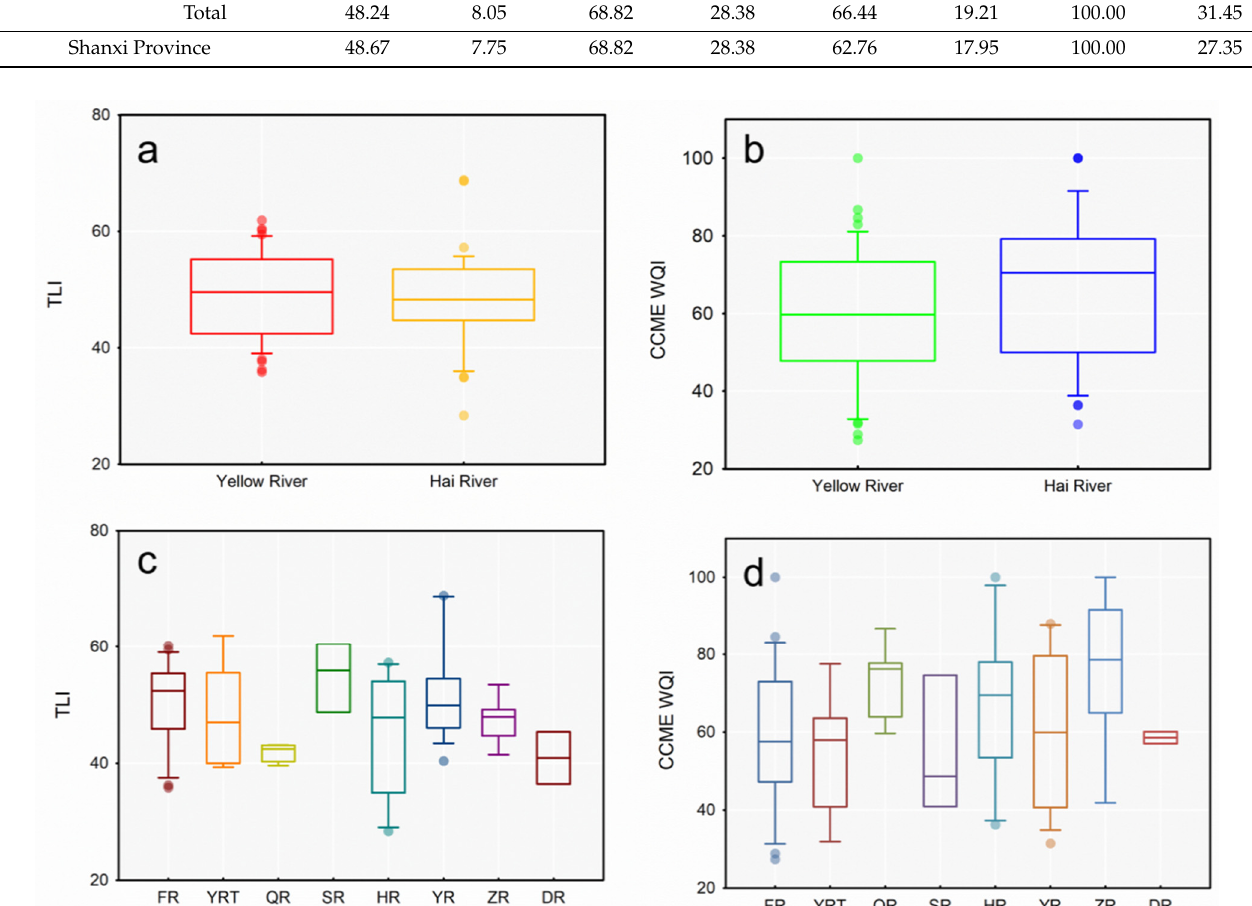
all rivers in Shanxi Province based on the spatial analysis model of ArcGIS (Figure 5a). The results showed that the TLI of all rivers were ranged from 43.07 to 54.76. The rivers’ TLI in Eutropher state was found in the southwest and north of Shanxi Province.